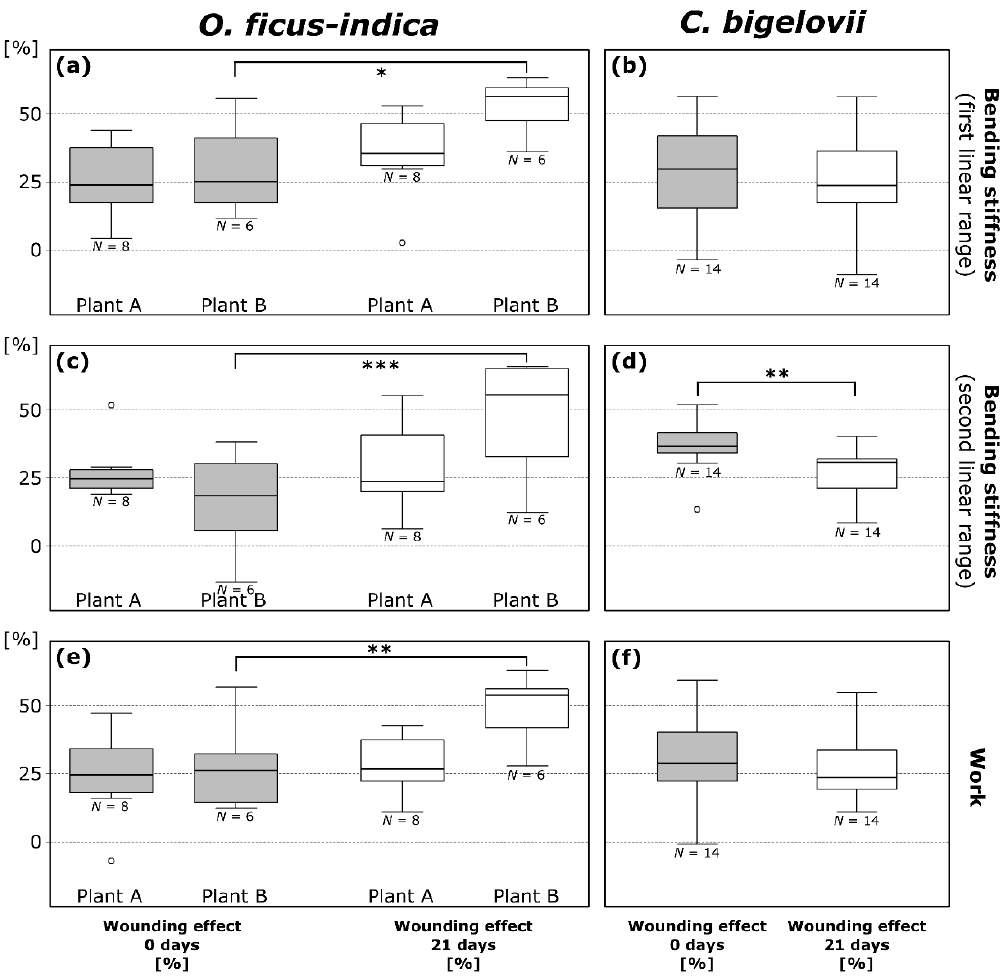
Figure 4. Wounding e ff ects (cf. Equation (3)) directly after ring incision (gray box-plots; calculated from the respective values in the wounded and unwounded state) and after a healing period of 21 days (white box-plots; calculated from the respective values in the healed and unwounded state) of bending sti ff ness in the first ( a , b ) and second ( c , d ) linear range and work ( e , f ) determined from repeated bending tests on branches of Opuntia ficus-indica and Cylindropuntia bigelovii . All data points outside the range of 1.5 IQR are considered outliers and are represented by an “o”. The values of the three plants of C. bigelovii are presented as pooled since no significant di ff erence was measured for any of the parameters. * p ≤ 0.05, ** p ≤ 0.01, *** p ≤ 0.001.